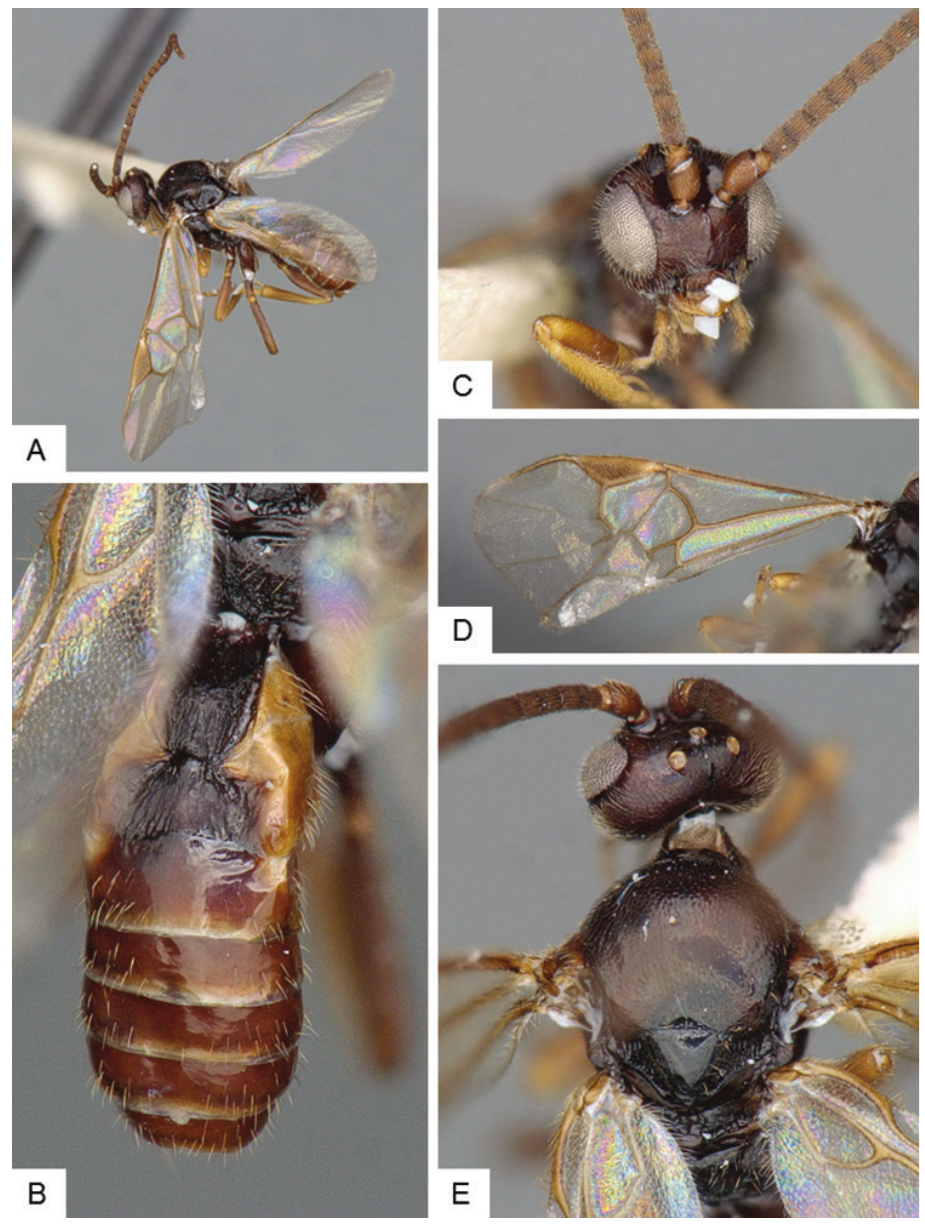
Figure 18. Glyptapanteles sp. 4. A Habitus, lateral B Metasoma, dorsal C Head, frontal D Fore wing E Head and mesosoma (partially),